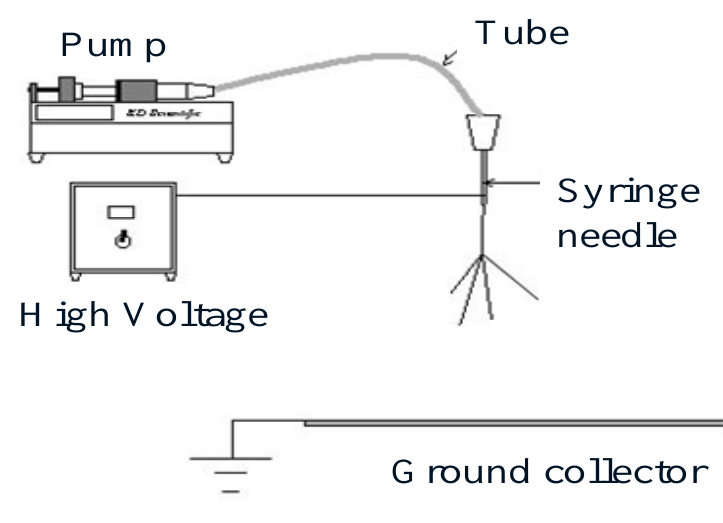
Figure 11. Diagram of the electrospinning set-up.